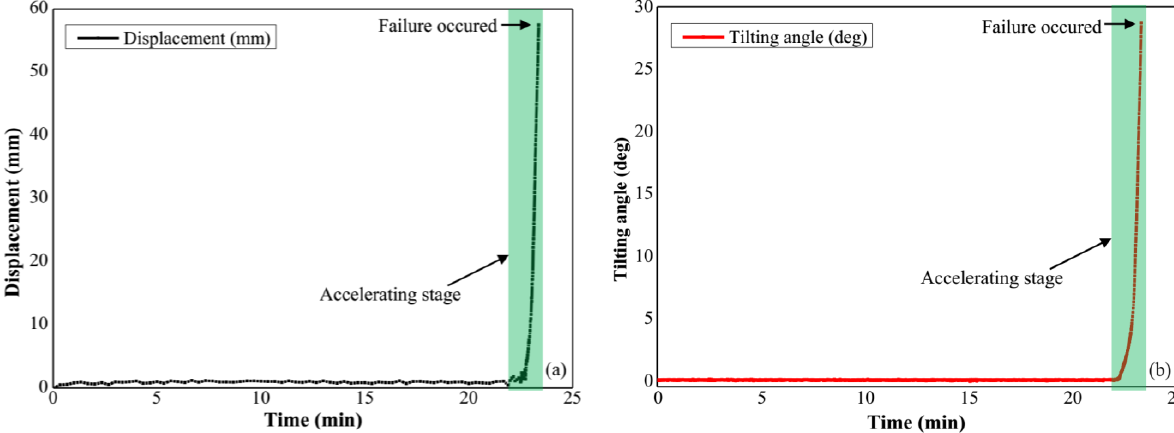
Figure 9. ( a ) Time history of the displacement at subsurface in Model Test 2, ( b ) time series of the tilting angle at the subsurface in Model Test 2.